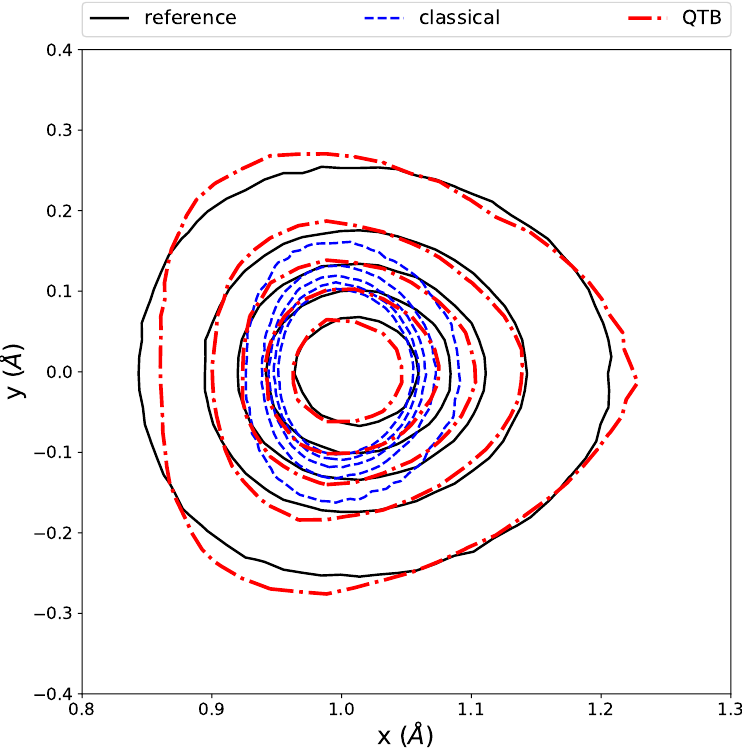
Figure 7. Quantum probability distribution (solid black), classical distribution (dotted blue) and QTB probability distribution (red), at T = 300 K for the 2D O–H potential. Contour levels are 1.0 Å − 2 , 5.0 Å − 2 , 9.0 Å − 2 , 13.0 Å − 2 , 17.0 Å − 2 .